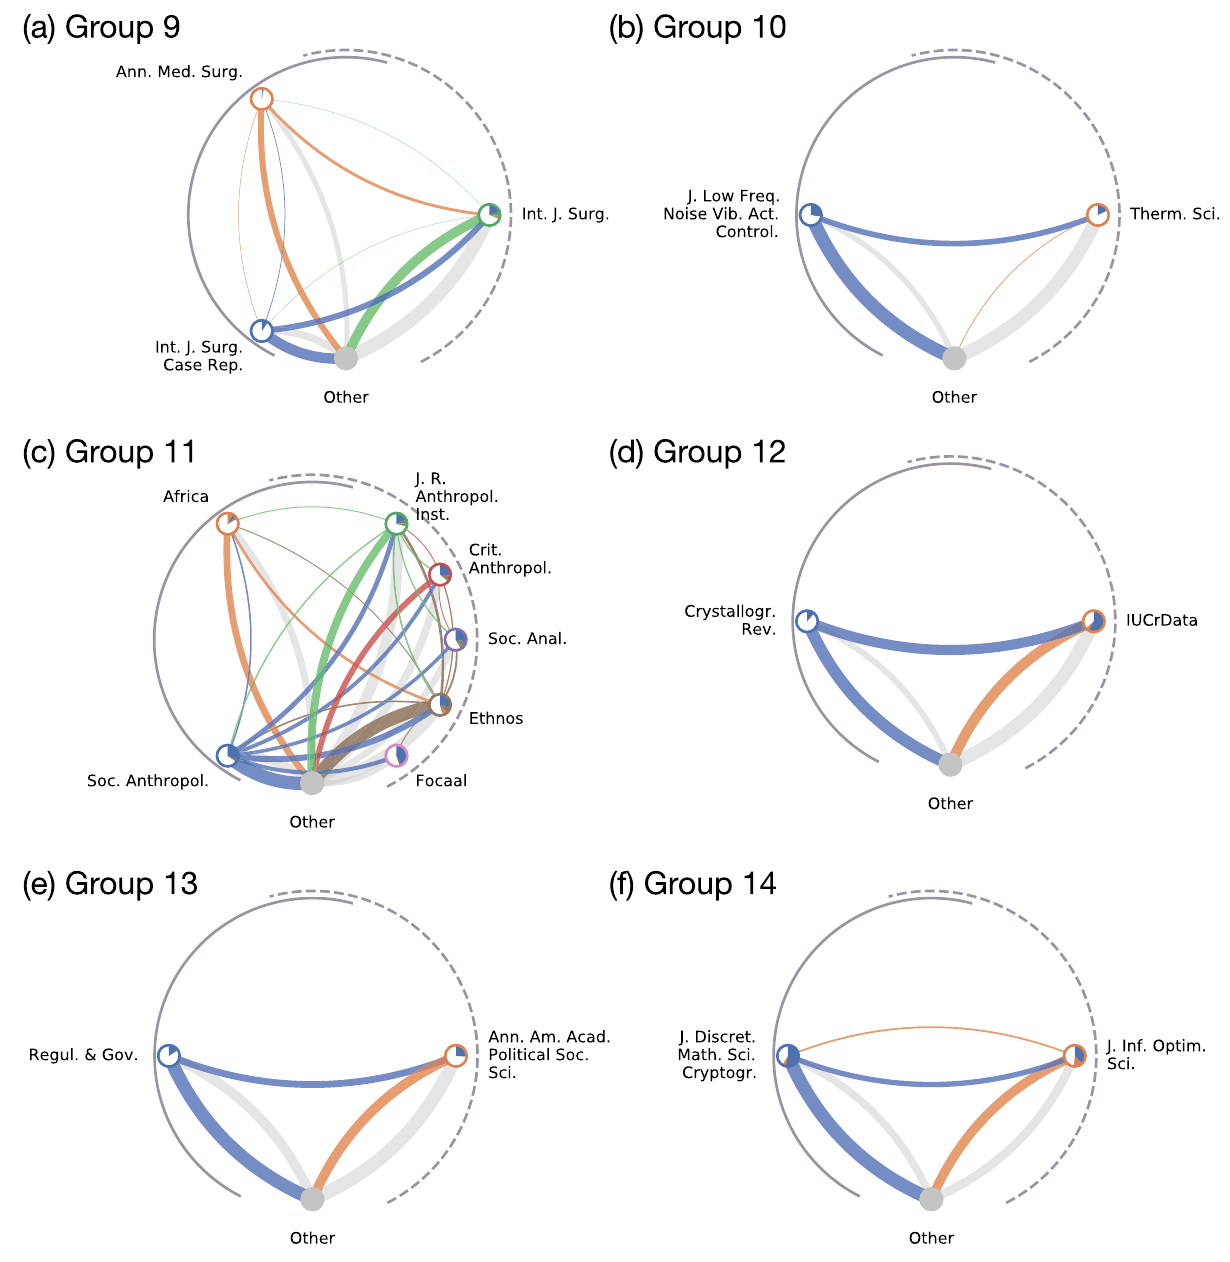
Figure 5. Citation groups that CIDRE detected for the network in